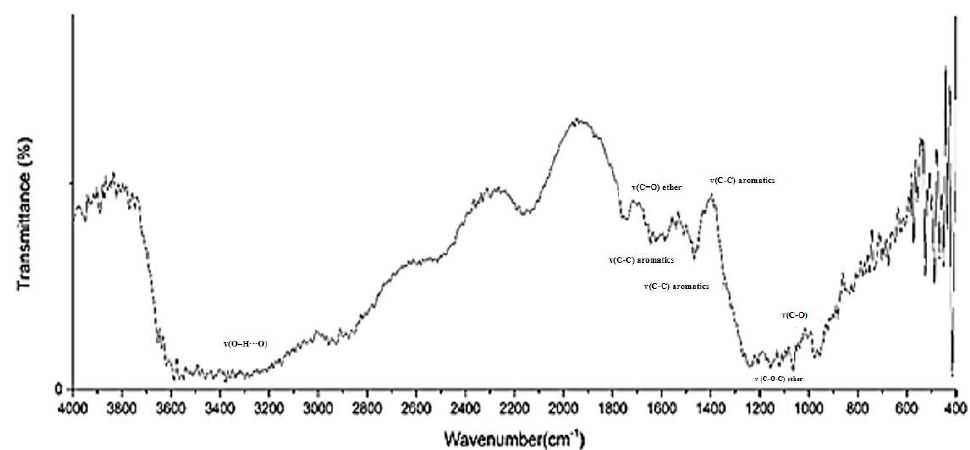
Fig. 2 The functional groups of FTIR spectrum on the surface of the djulis seed. Figure 2. The functional groups of FTIR spectrum on the surface of the djulis seed.